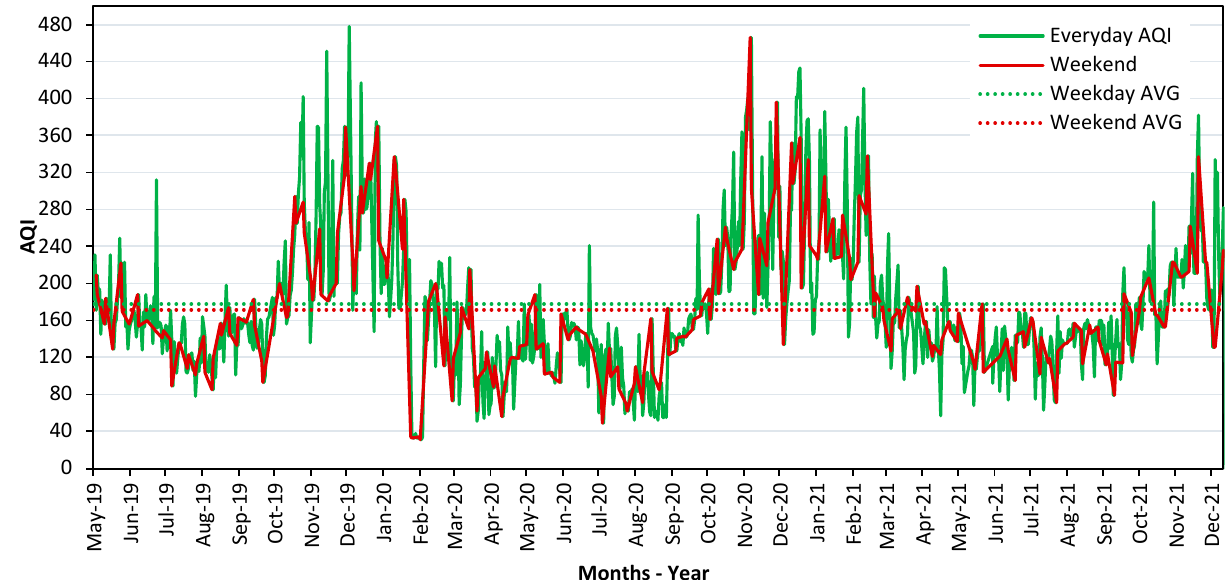
Figure 8. The daily trend of AQI in Lahore to identify the difference in weekday and weekend